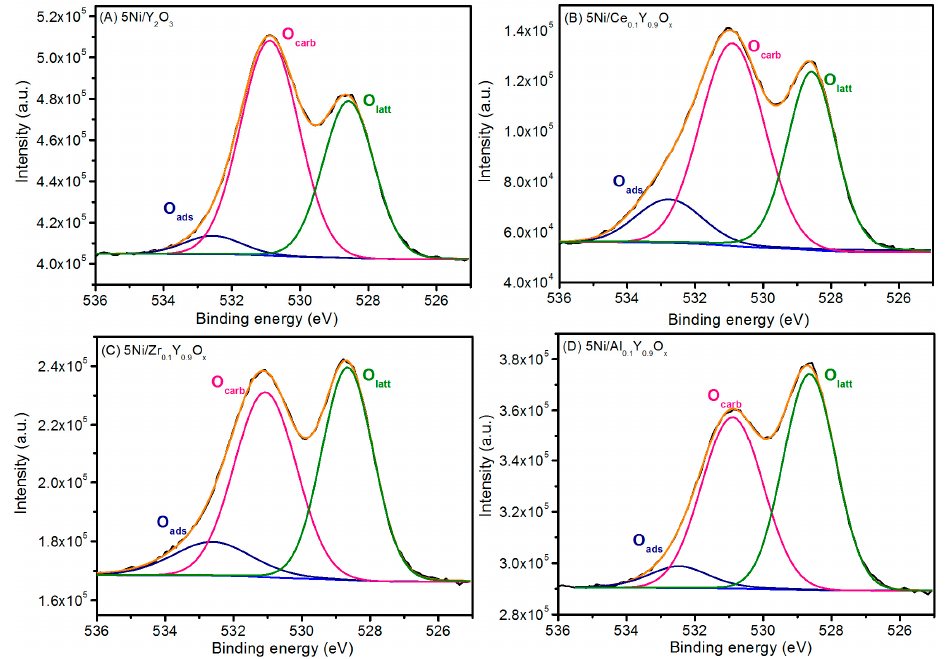
Figure 8. XPS O 1s spectra of the fresh catalysts. ( A ) 5Ni/Y 2 O 3 , ( B ) 5Ni/Ce 0.1 Y 0.9 O x , ( C )